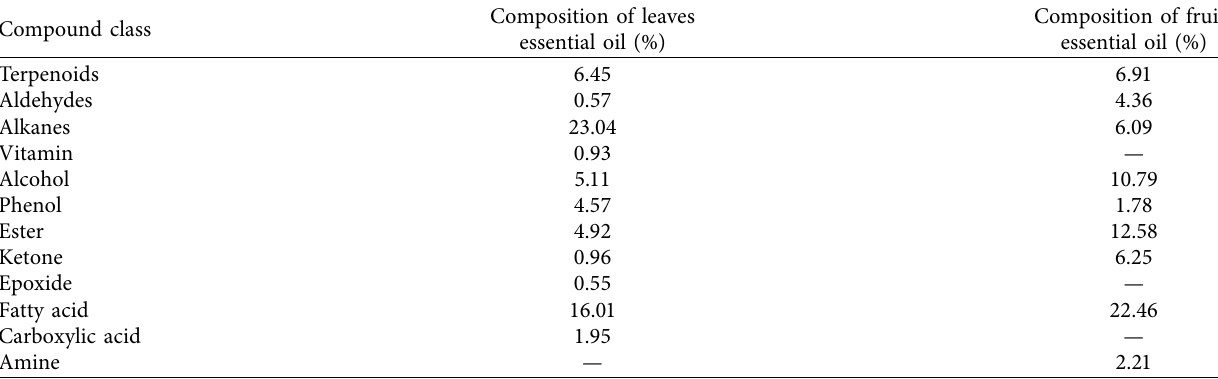
Table 3: Classes of compounds identifed in Vitex doniana leaf and fruit essential oils.